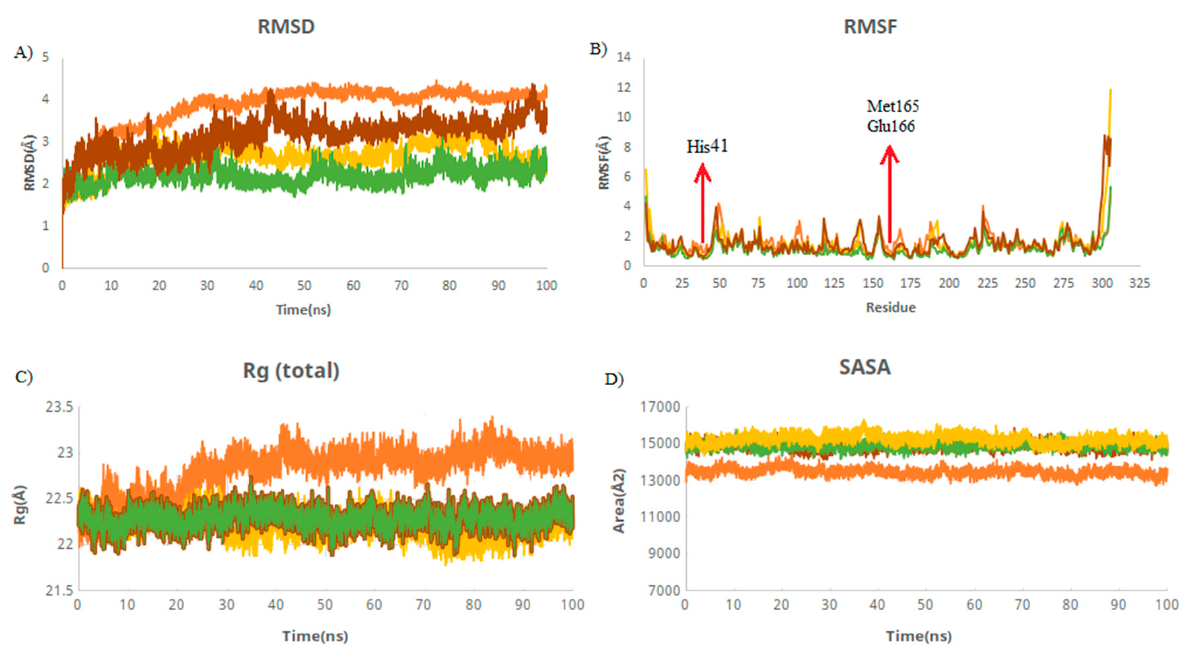
Figure 3. Structural dynamics of M protein. ( A ) Root mean square deviation (RMSD), ( B ) root mean square fluctuations (RMSF), ( C ) radius of gyration (Rg) plot, and ( D ) solvent-accessible surface area (SASA). Orange color indicates M protease-free form; yellow, green, and brown indicate M protease in a complex with M9, M7, and griseofulvin, respectively. Table 2. The average of RMSD, RMSF, Rg, and SASA for M protease during the last 20 ns of MD